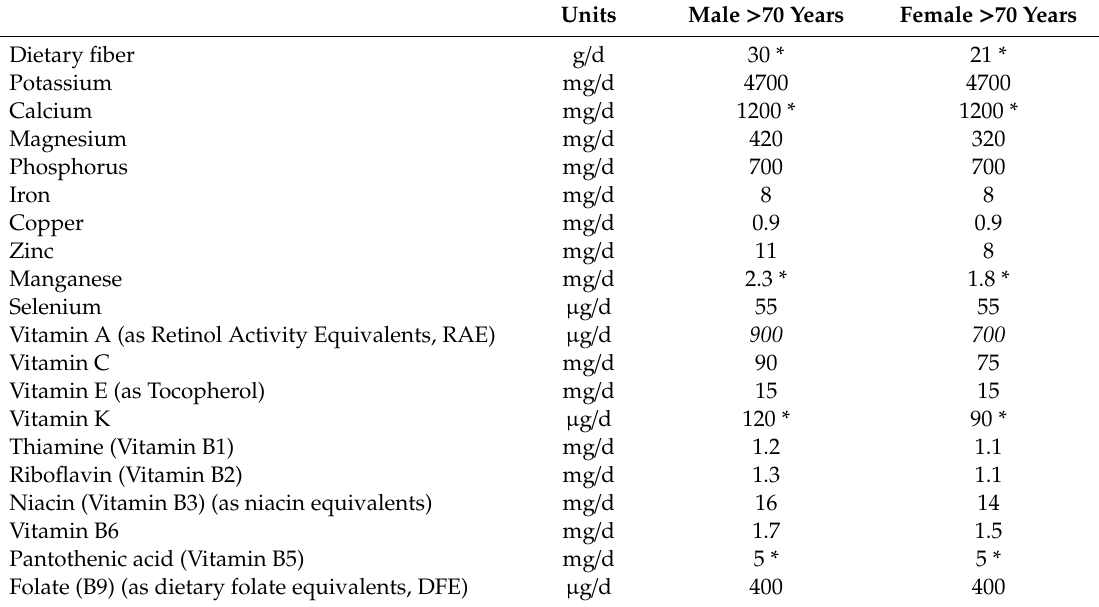
Table 2. US Recommended dietary allowances (RDAs) or adequate intakes (AIs) of nutrients for people > 70 years